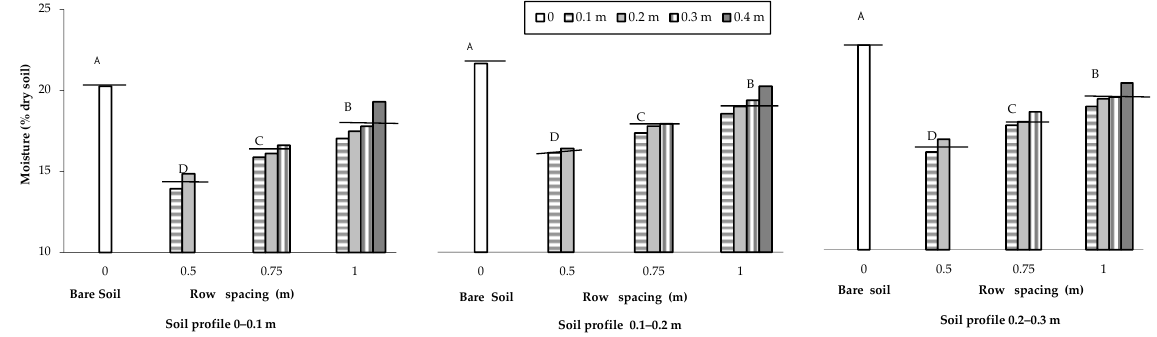
Figure 4. Moisture content of the bare and cultivated soils as influenced by the change in row spacing (0 m vs. 0.5, 0.75 and 1 m), along the soil depth and distance from the row (0.1, 0.2, 0.3 and 0.4 m). The horizontal lines over the bars represent the mean values of the groups. The group means with the same letter within each soil profile are not significantly different (SNK test at p = 0.01).